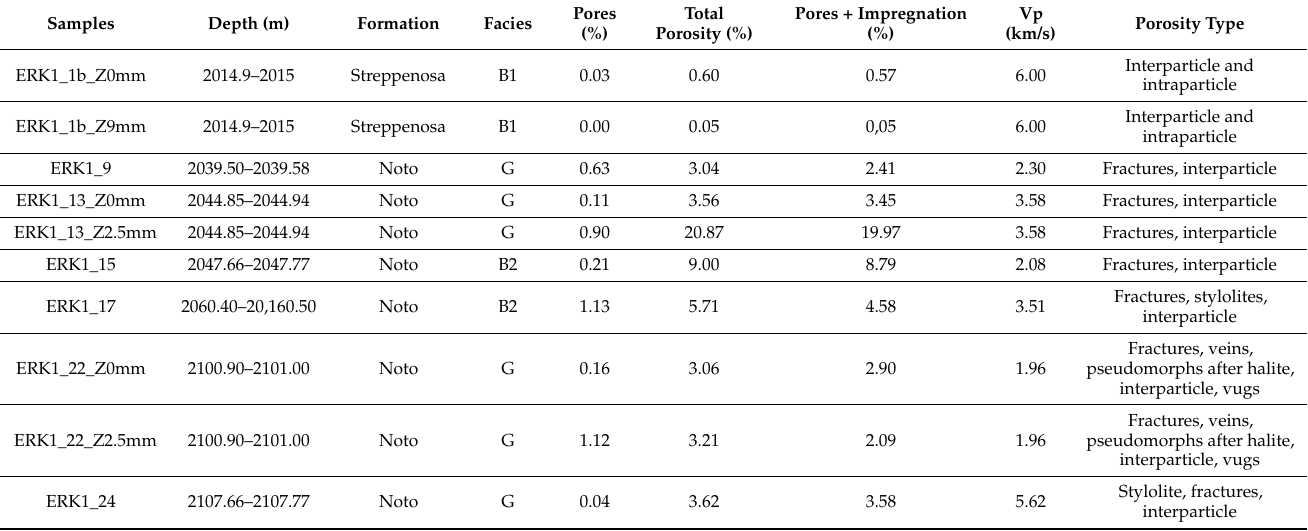
Table 3. Porosity results of quantitative analysis, based on 3D images from samples at different depth, versus sedimentary facies, P-waves velocities obtained from core samples, and type of